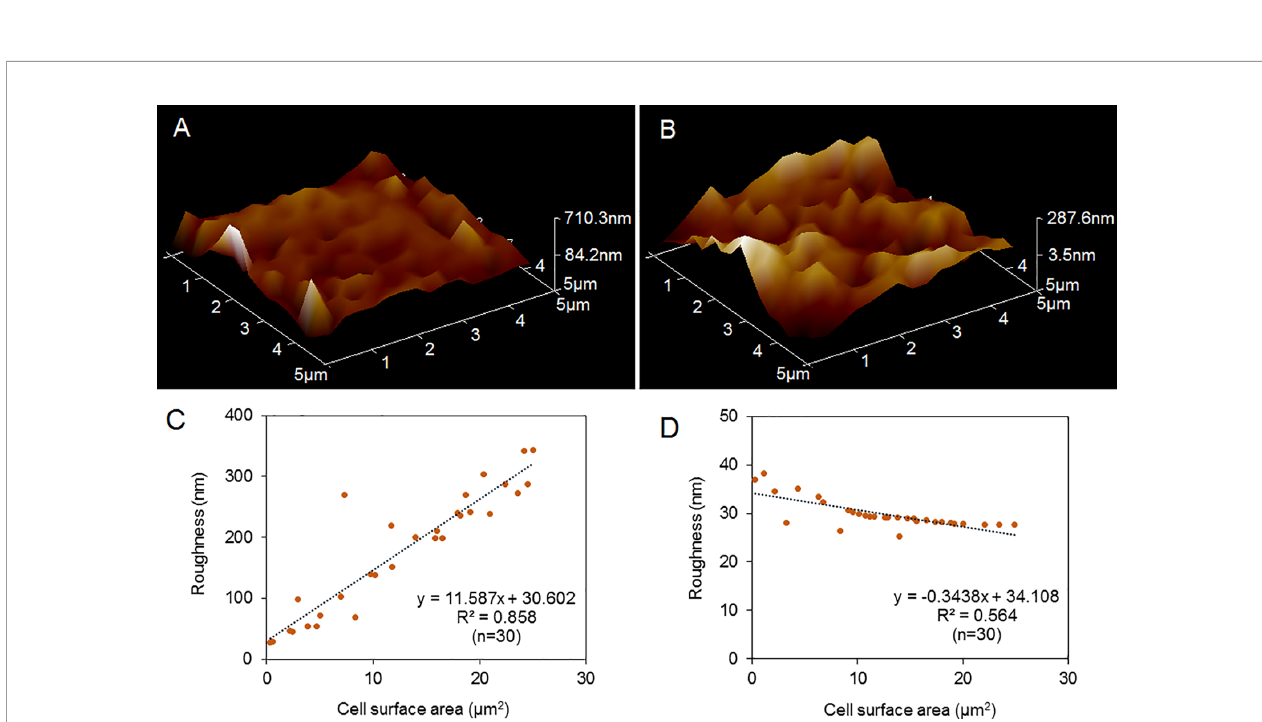
FIGURE 5 | Comparison of the cell surface roughness of P. donghaiense. (A) 3D morphology of P. donghaiense under normal culture conditions. (B) 3D morphology of P. donghaiense under nitrogen limiting conditions. (C) Statistical analysis of roughness under normal culture conditions. (D) Statistical analysis of roughness under nitrogen limiting